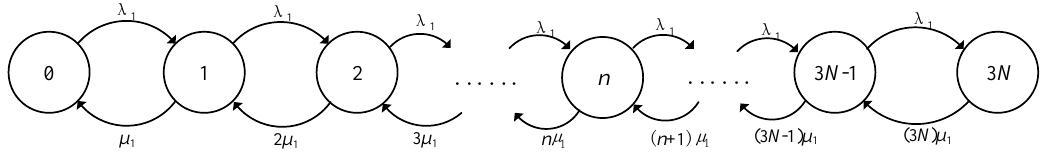
Figure 3. The survivability model of the V2I link failure.